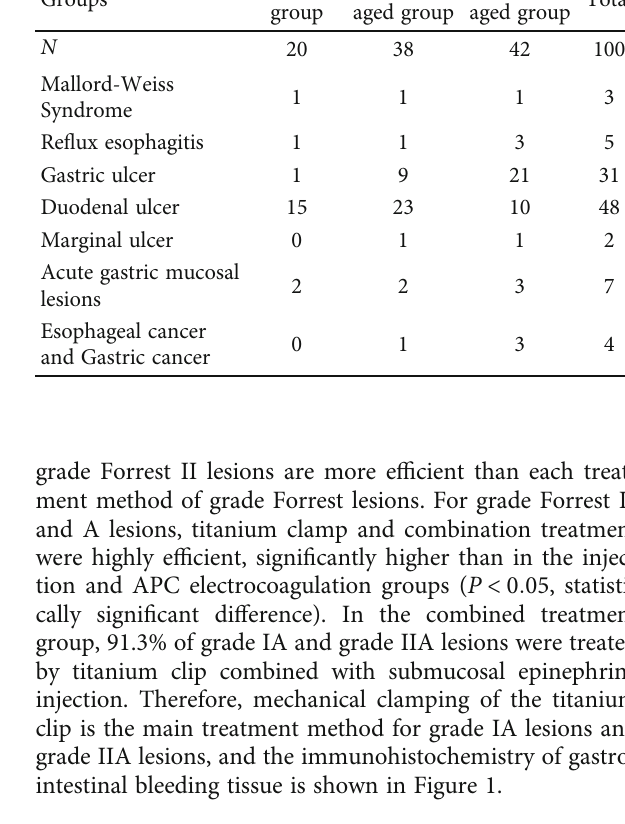
Table 2: Etiological composition in di ff erent age groups.